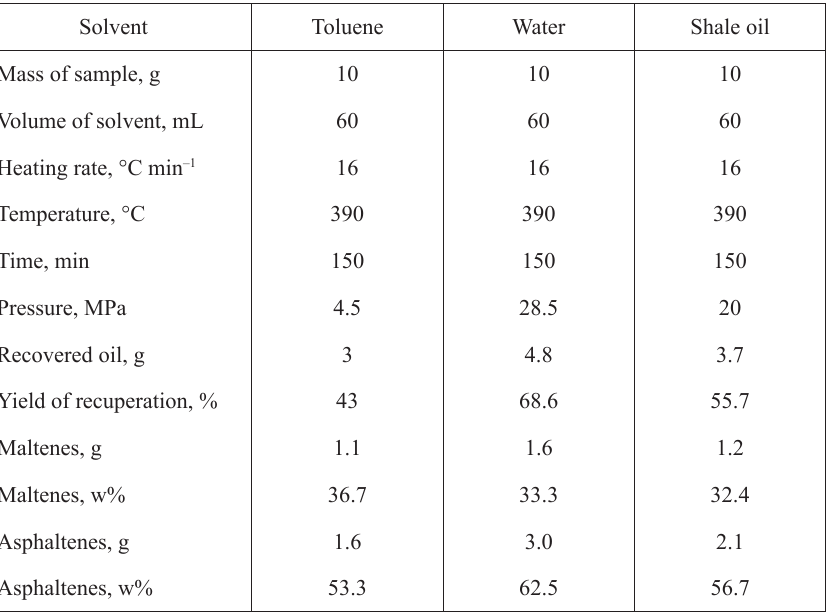
Table 6. Yields and composition of the oils extracted from RH by different